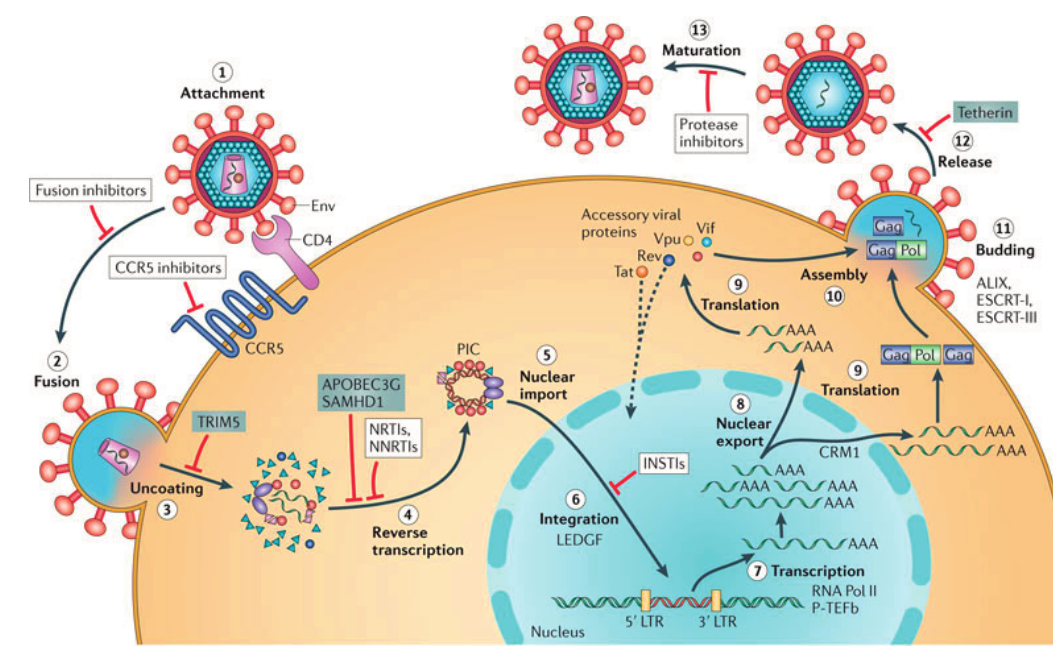
Figure 1. Schematic representation of the replication cycle of HIV (reproduced from Ref. [9] with permission of Nature Publishing Group). The infection begins when the glycoprotein gp120, exposed on the surface of the HIV envelope (Env), recognizes and interacts with the receptor CD4 and the membrane-spanning co-receptor CC-chemokine receptor 5 (CCR5) (step 1), leading to fusion of the viral and cellular membranes and entry of the viral particle into the cell (step 2). Partial core shell uncoating (step 3) facilitates reverse transcription (step 4), which in turn yields the pre-integration complex (PIC). Following import into the cell nucleus (step 5), PIC-associated integrase leads to the formation of the integrated provirus, aided by the host chromatin-binding protein lens epithelium-derived growth factor (LEDGF) (step 6). Proviral transcription (step 7), mediated by host RNA polymerase II (RNA Pol II) and positive transcription elongation factor b (P-TEFb), yields viral mRNAs of different sizes, the larger of which require energy-dependent export to leave the nucleus via host protein CRM1 (Chromosomal Region Maintenance 1 protein, also known as Exportin 1) (step 8). mRNAs serve as templates for protein production (step 9), and genome-length RNA is incorporated into viral particles with protein components (step 10). Viral-particle budding (step 11) and release (step 12) from the cell is mediated by ESCRT (endosomal sorting complex required for transport) complexes and ALIX (ALG-2-interacting protein X) and is accompanied or soon followed by protease-mediated maturation (step 13) to create an infectious viral particle. Each step in the HIV life cycle is a potential target for antiviral intervention; the sites of action of clinical inhibitors (white boxes) and cellular restriction factors (blue boxes) are indicated. INSTI, integrase strand transfer inhibitor; LTR, long terminal repeat; NNRTI, non-nucleoside reverse transcriptase inhibitor; NRTI, nucleoside reverse transcriptase